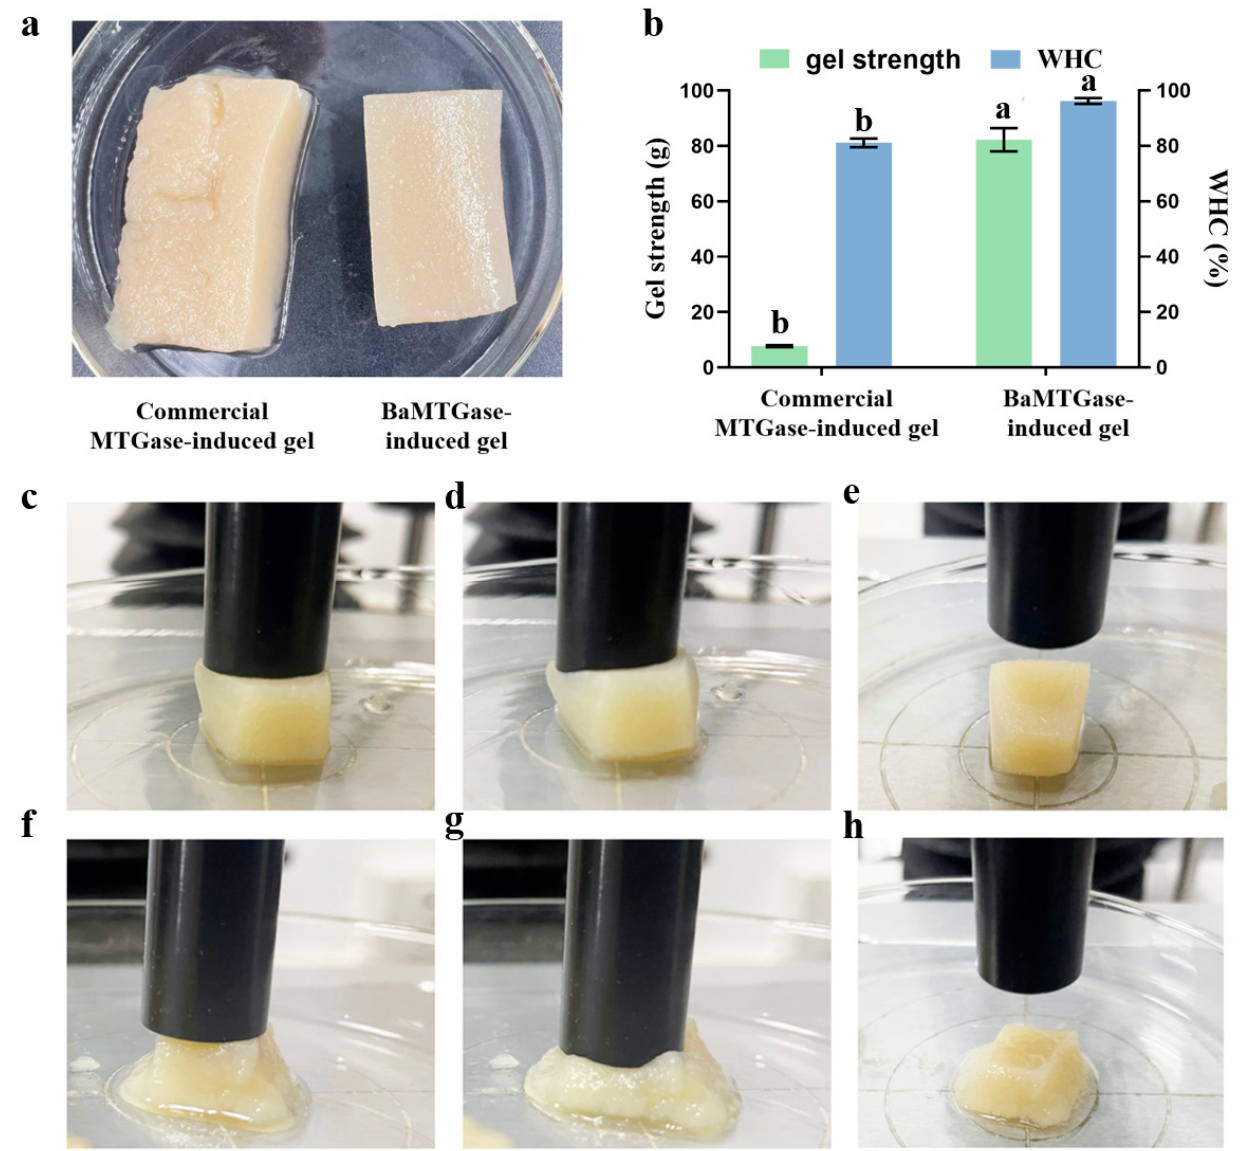
Figure 4. Gel strength and WHC of SPI gels. ( a ) Visual comparison of gels induced by commercial MTGase and recombinant BaMTGase. ( b ) Gel strength and WHC of SPI gels crosslinked by commercial MTGase and BaMTGase. ( c ) Morphological changes of the gel induced by BaMTGase when the texture analyzer touched the surface. ( d ) Morphological changes of BaMTGase-induced gel when the instrument squeezed gels. ( e ) Morphological changes of BaMTGase-induced gel after squeezing. ( f ) Morphological changes of commercial MTGase-induced gel when the texture analyzer touched the surface. ( g ) Morphological changes of commercial MTGase-induced gel when the instrument squeezed the gel. ( h ) Morphological changes of commercial MTGase-induced gel after squeezing. Letters above the bars in ( b ) indicate significant differences ( p < 0.05).